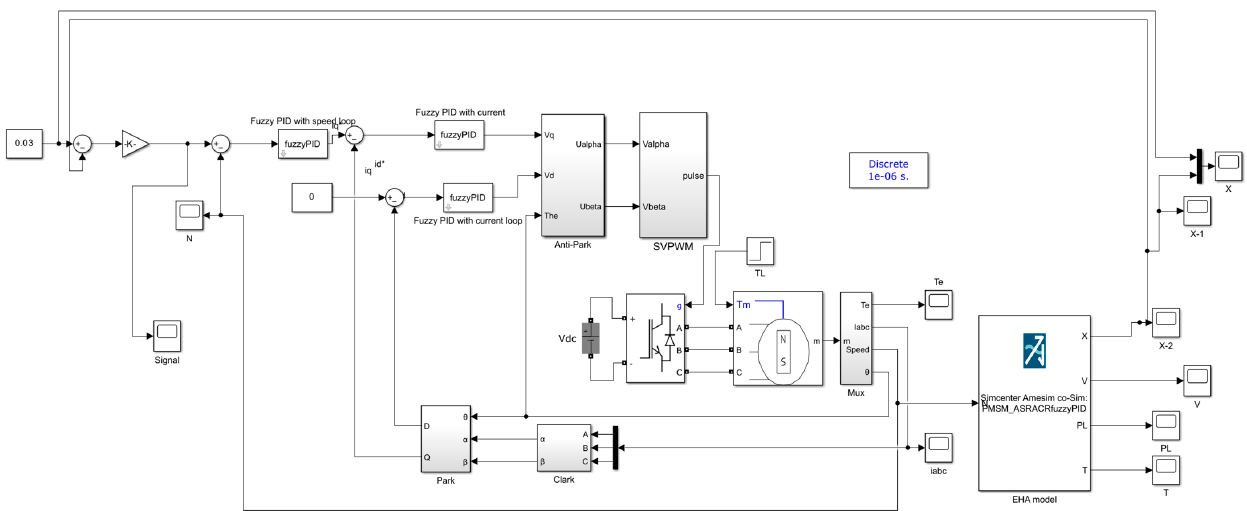
Figure 12. Simulink–Amesim co-simulation Simulink model. Table 2. EHA system simulation parameters.